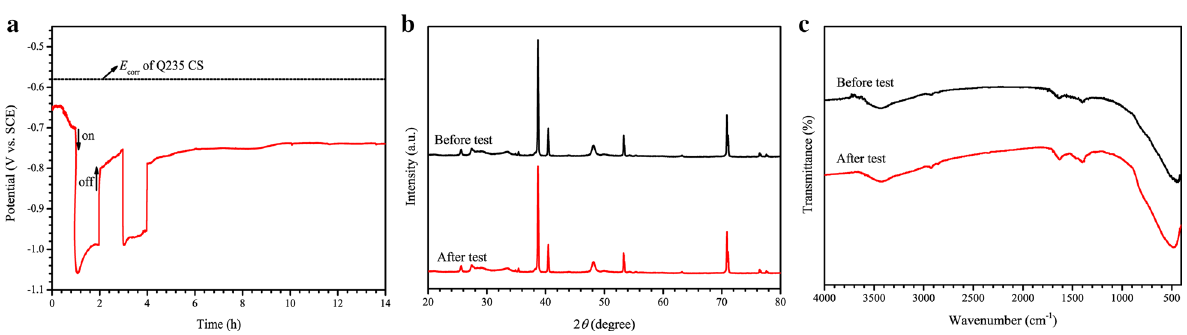
Fig. 8 a Long-term potential changes of Q235 CS connected to the SnIn 4 S 8 /TiO 2 composite under intermittent visible light illumination; b XRD patterns of the SnIn